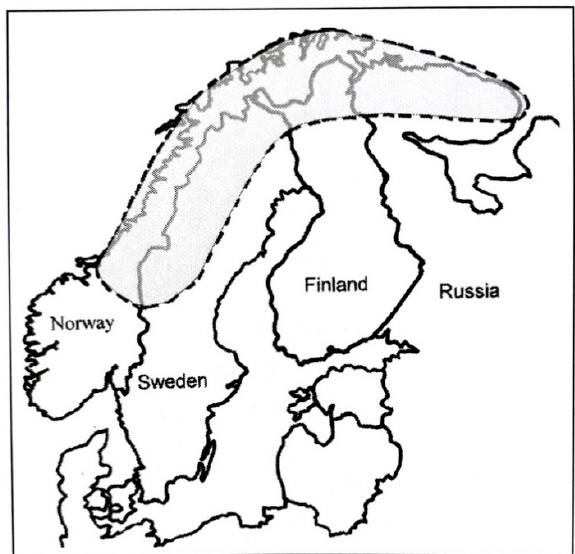
Figure 1. Area of Sami population.